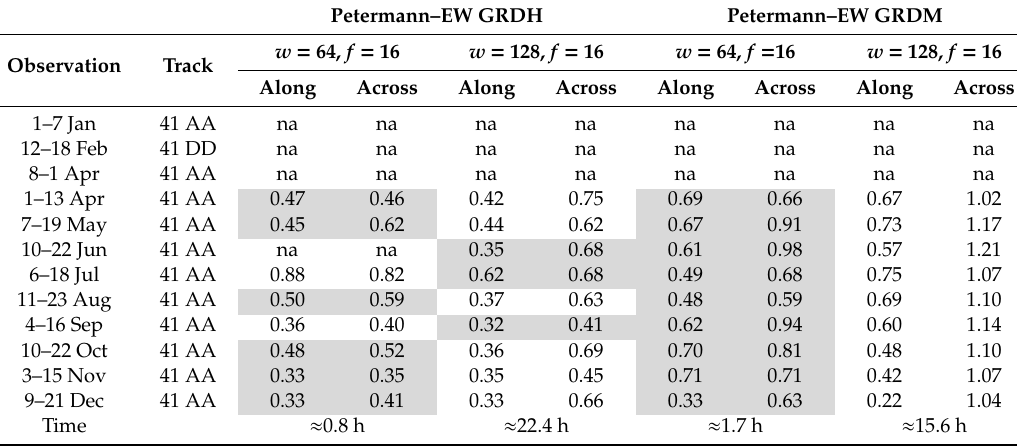
Table 5. PG, EW GRDH and EW GRDM product classes experiments, RMSE (expressed in m / day) with respect to available literature data measured along selected along flow and across flow